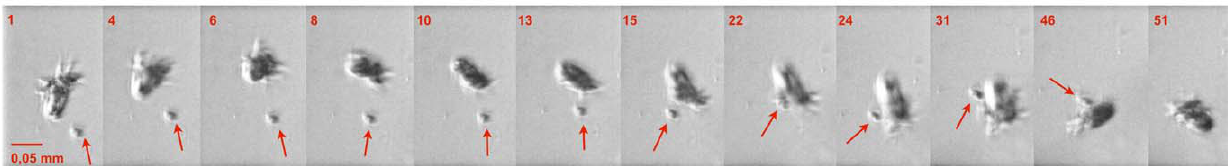
Figure 6. Prey capture in Oithonadavisae . Time series of still images with frame numbers indicated (consecutive frames are 0.5 ms apart). Arrows point towards the prey. In the last image the prey has been captured.